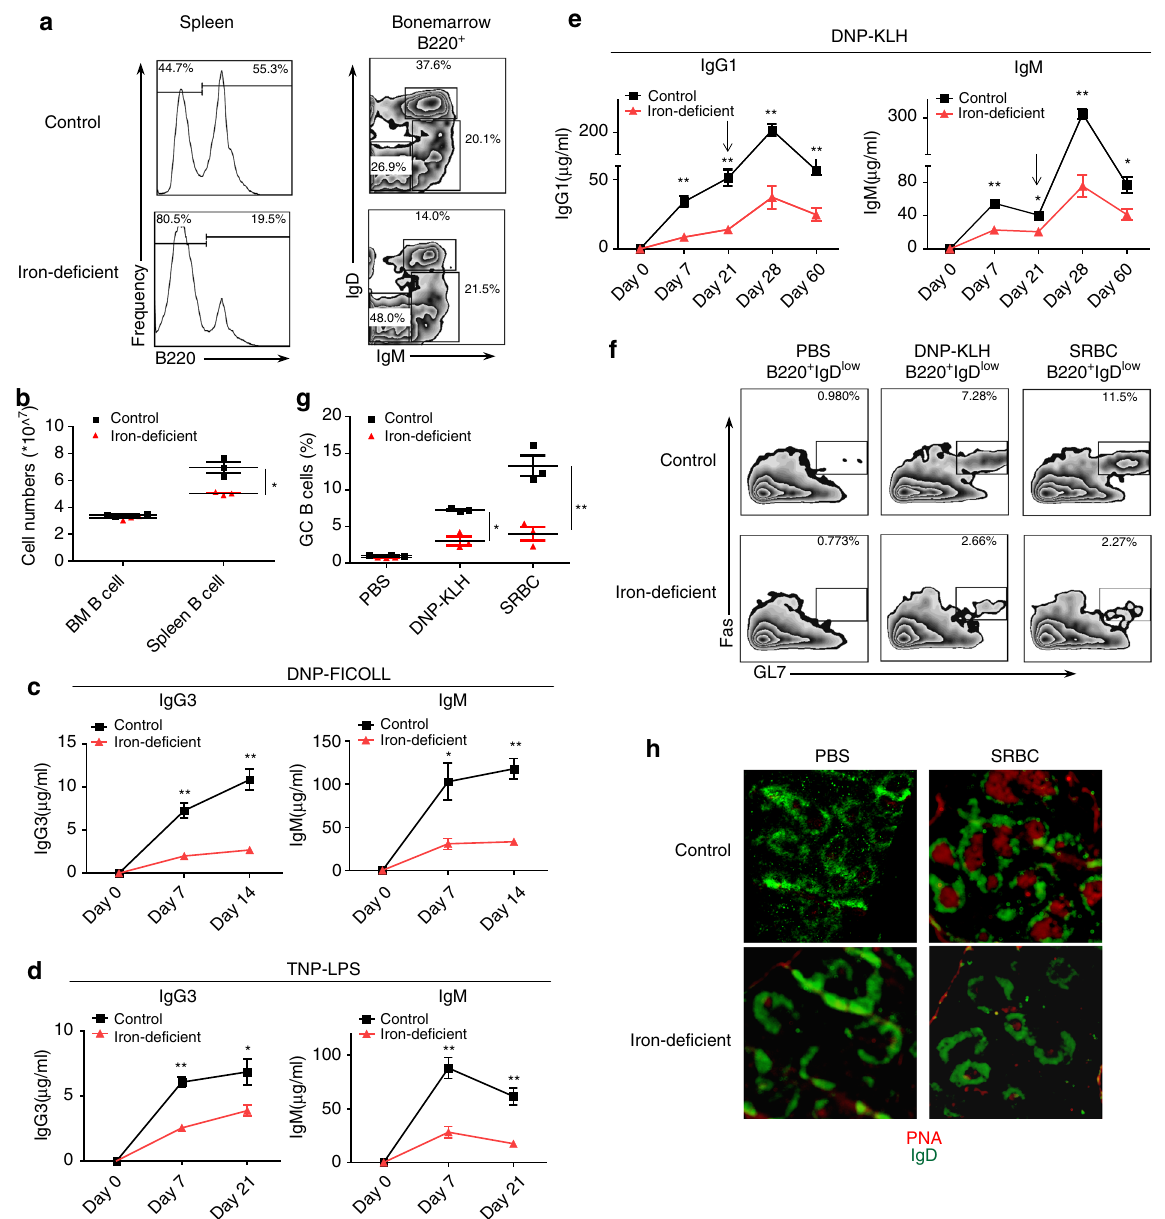
Fig. 2 Iron de fi ciency results in impaired TD and TI immune responses in mice. Three-week-old wild-type C57BL/6J mice (male) were divided into two groups and fed either a control iron-adequate diet (45.4 mg/kg iron) or an iron-de fi cient diet (0.9 mg/kg iron) for 5 weeks. a Flow cytometry of splenocytes from control and iron-de fi cient mice stained with anti-B220 to identify peripheral B cells. Bone marrow cells from control and iron-de fi cient mice were stained with anti-B220, anti-IgM, and anti-IgD antibodies to assess pre- and pro-B cells (IgM − IgD − ), immature B cells (IgM + IgD int ), and mature circulating B cells (IgM + IgD hi ). b Statistics for the numbers of splenic B cells in the two groups (mean ± SEM of three mice per group). c – e Antigen-speci fi c antibody responses of control and iron-de fi cient mice immunized with DNP-KLH (TD), DNP-Ficoll (TI-2), or TNP-LPS (TI-1). Serum was collected preimmunization and at 7 days and 21 days after immunization. In the case of DNP-KLH, the mice were rechallenged at day 21 as indicated by the arrow, and serum was collected at day 28 and to a long-term at day 60 (the data represent the mean ± SEM of four mice per group). f Control and iron-de fi cient mice were immunized with SRBCs, DNP-KLH or PBS as a control, and at day 10, splenocytes were stained with anti-B220, anti-IgD, anti-GL7, and anti- CD95 (Fas) antibodies to assess the GCB cells (B220 + IgD low GL7 + Fas + ). g Statistics for the proportions of GCB cells in mice immunized with DNP-KLH or SRBCs (mean ± SEM of three mice per group). h Frozen sections of spleens from mice immunized with SRBCs were stained with anti-IgD antibody and PNA to identify germinal center reactions. The data were representative of at least two independent experiments. * P < 0.05, ** P < 0.01, Student ’ s t -test CD45.1 + wild-type and CD45.2 + wild-type bone marrow (1:1), Steap3-KO mature B cells, indicating that reduced number of no difference was observed between CD45.1 + wild-type and mature B cells caused by Steap3 depletion were intrinsic to B cells CD45.2 + wild-type B-cell populations. However, mice that (Fig. 3e, f). Notably, neither type of bone marrow chimeric mouse displayed obvious differences in the percentages of MZB and received CD45.1 + wild-type and CD45.2 + Steap3-KO bone marrow (1:1) had more CD45.1 + mature B cells than CD45.2 + FOB cells among CD45.1 + and CD45.2 + mature B cells NATURE COMMUNICATIONS| (2019) 10:2935